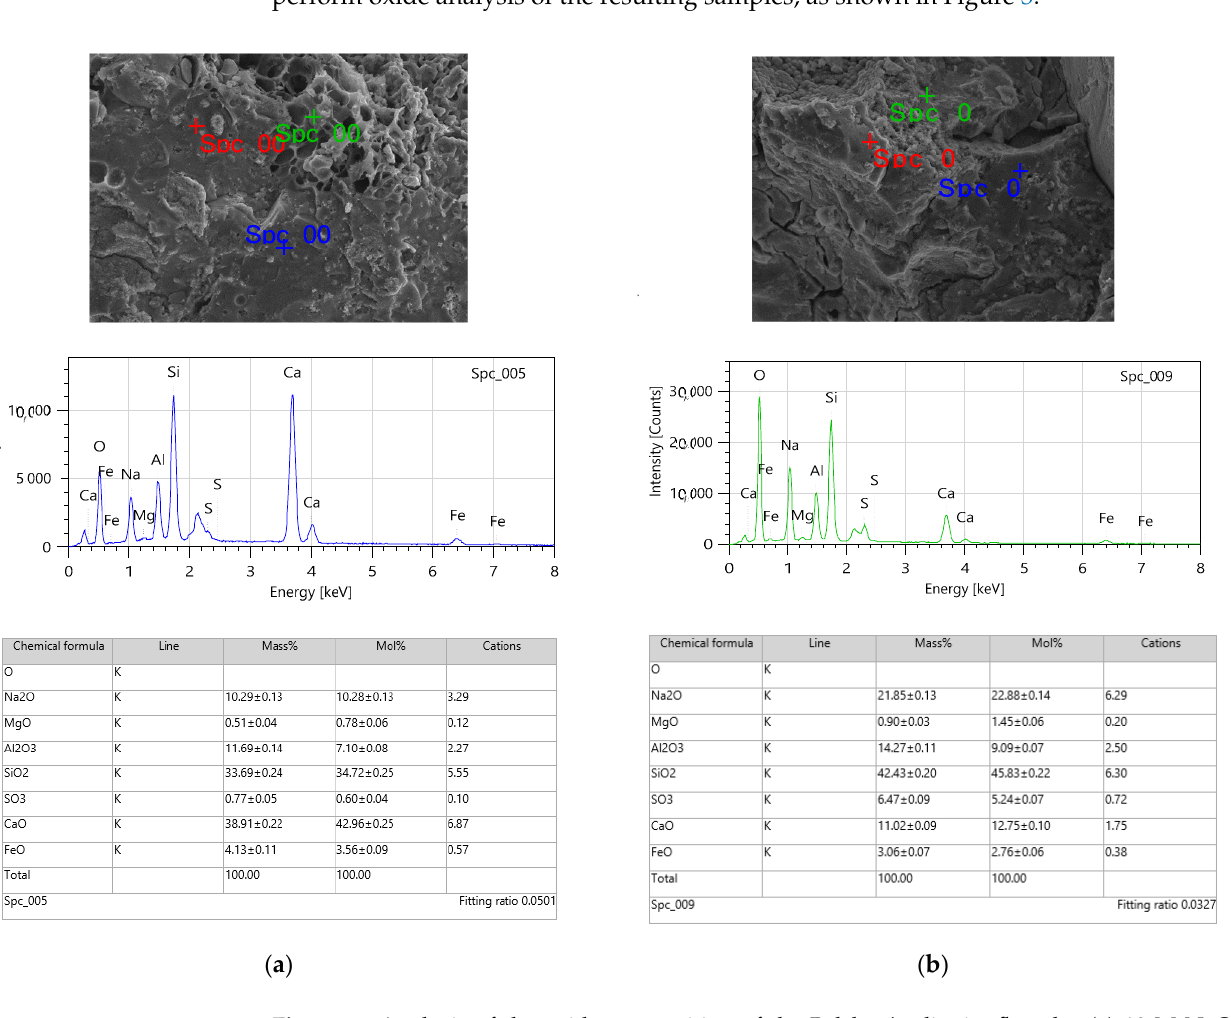
Figure 3. Analysis of the oxide composition of the Belchatów lignite fly ash—( a ) 10 M NaOH, ( b ) 14 M NaOH.